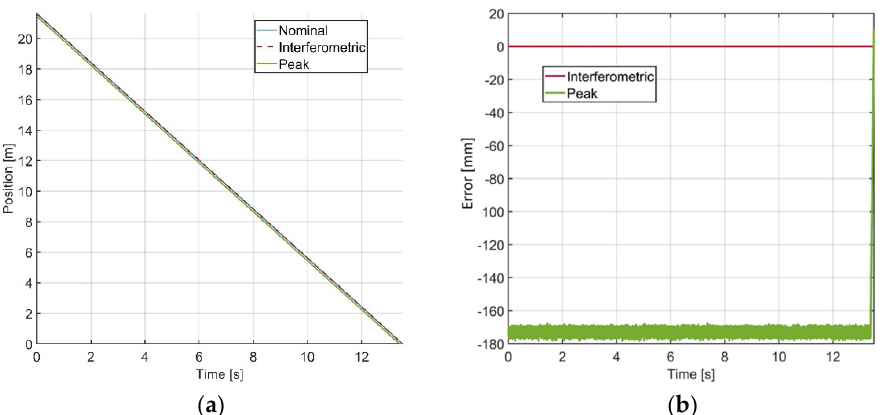
5 of 9 Figure 4. Radar image of GPR with speed of 1.6 m/s . Figure 5a shows the position retrieved by interferometry using Equation (8) (red line)